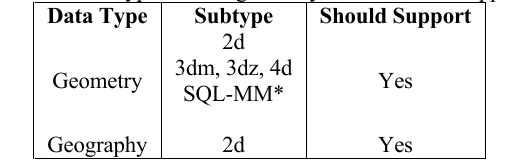
Table 1: Data type that the geometry viewer should support Data Type